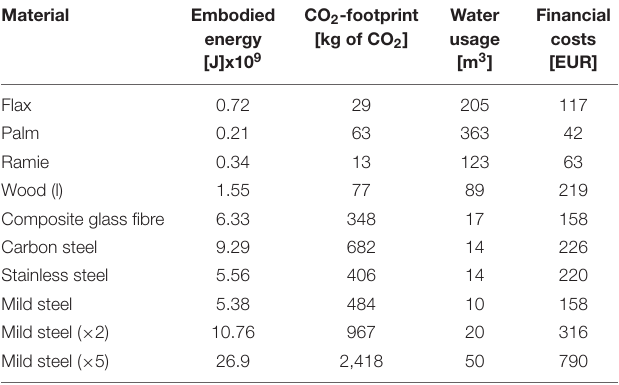
TABLE 5 | Environmental and financial costs for eight